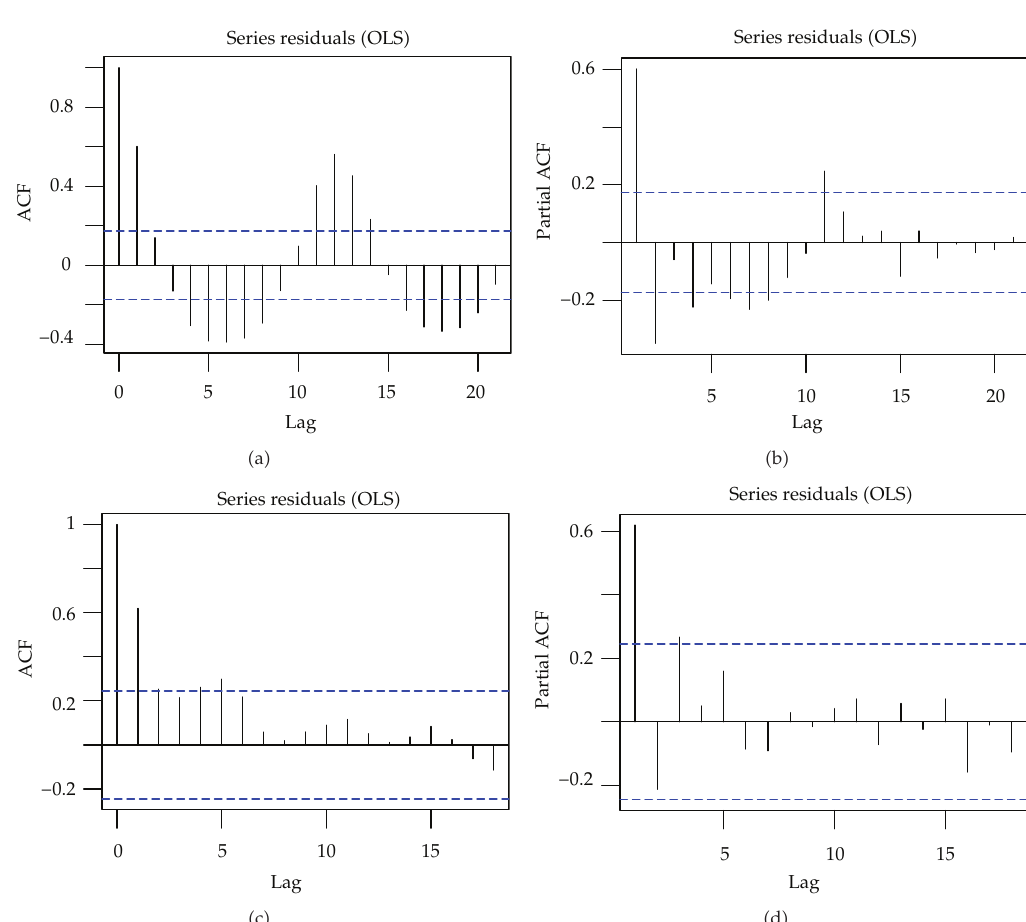
Figure 4: Autocorrelation and partial-autocorrelation functions for the residuals from the OLS method. The first row is for first data, while the second row is for the second data.